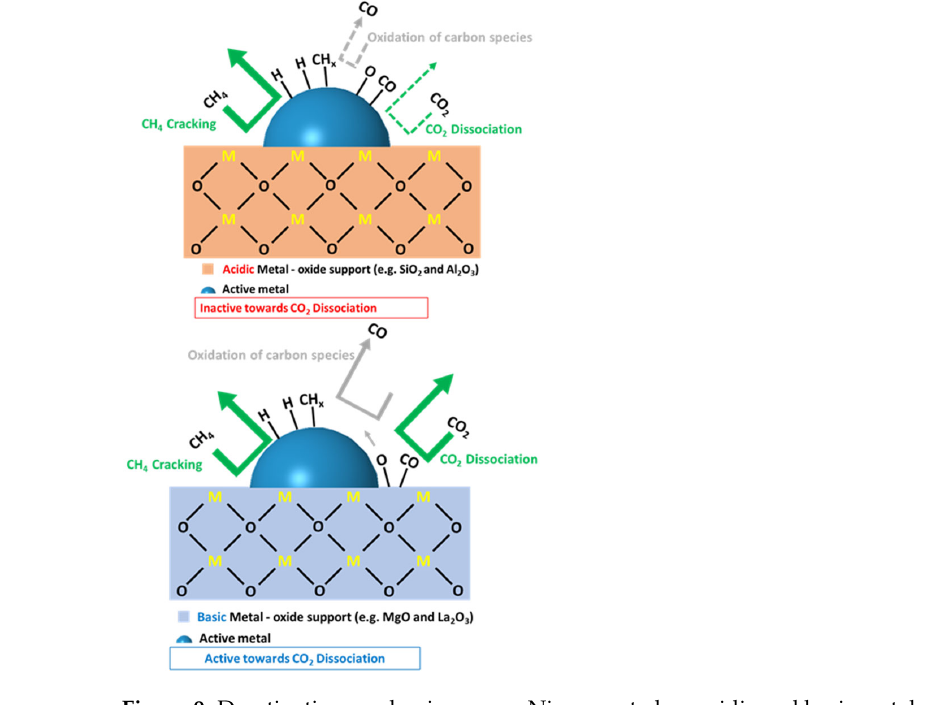
Figure 9. Deactivation mechanisms over Ni supported on acidic and basic metal ‐ oxide supports.